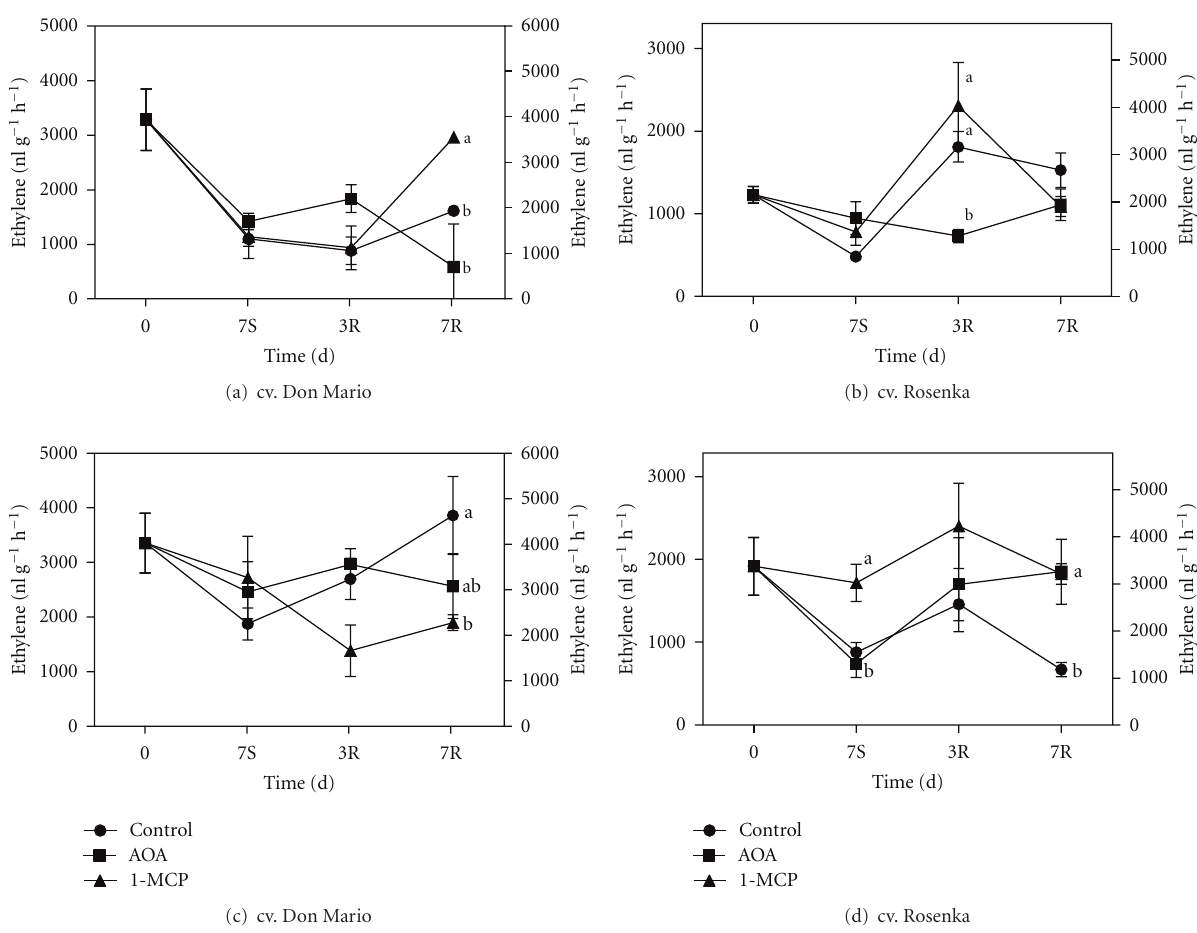
Figure 3: Ethylene production from leaves of cv. Don Mario (a) and cv. Rosenka (b) and from flowers of cv. Don Mario (c) and cv. Rosenka (d) stored for 7 days (7S) at 14 ◦ C and transferred at 20 ◦ C for recovery evaluation (3R and 7R). Values are means with standard errors ( n = 10). Data were subjected to one-way ANOVA, and di ff erent letters, when present, mean that values are statistically di ff erent, P < 0 . 05.